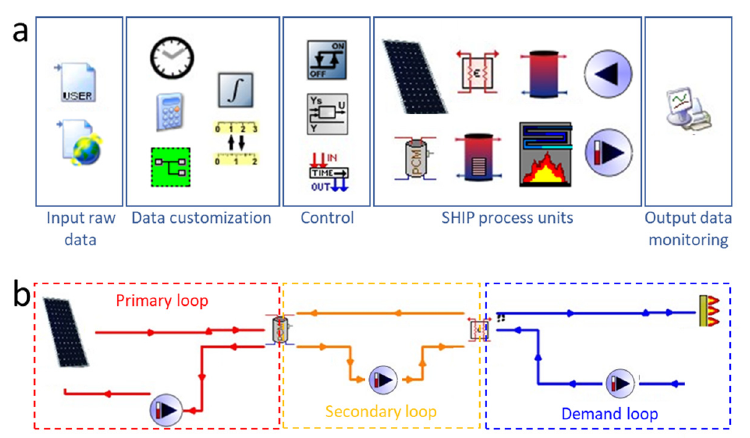
Figure 3. ( a ) TRNSYS types and their corresponding icons sorted by role; ( b ) typical three-loop circuit adopted for the simulation of the different SHIP integration options along this work. “Input raw data” types are used to read weather and irradiance historical data at the selected location as well as to read historical production data files and incorporate the transient process demand conditions (temperature, pressure and flowrate) to the model.